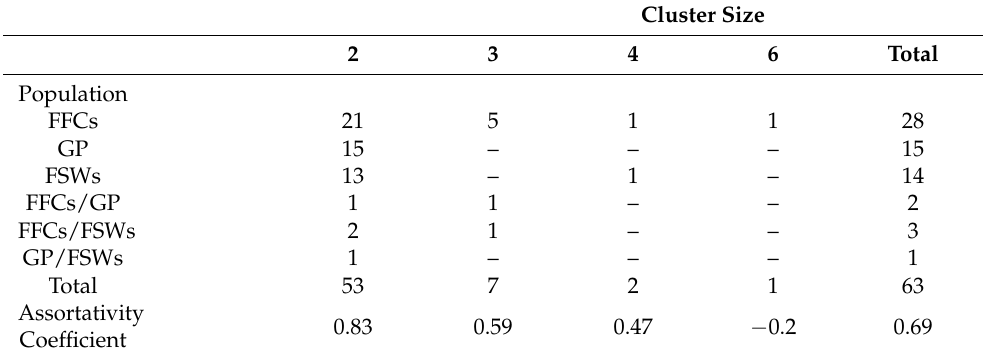
Table 2. Cluster Size according to population for networks generated at a TD of ≤ 5